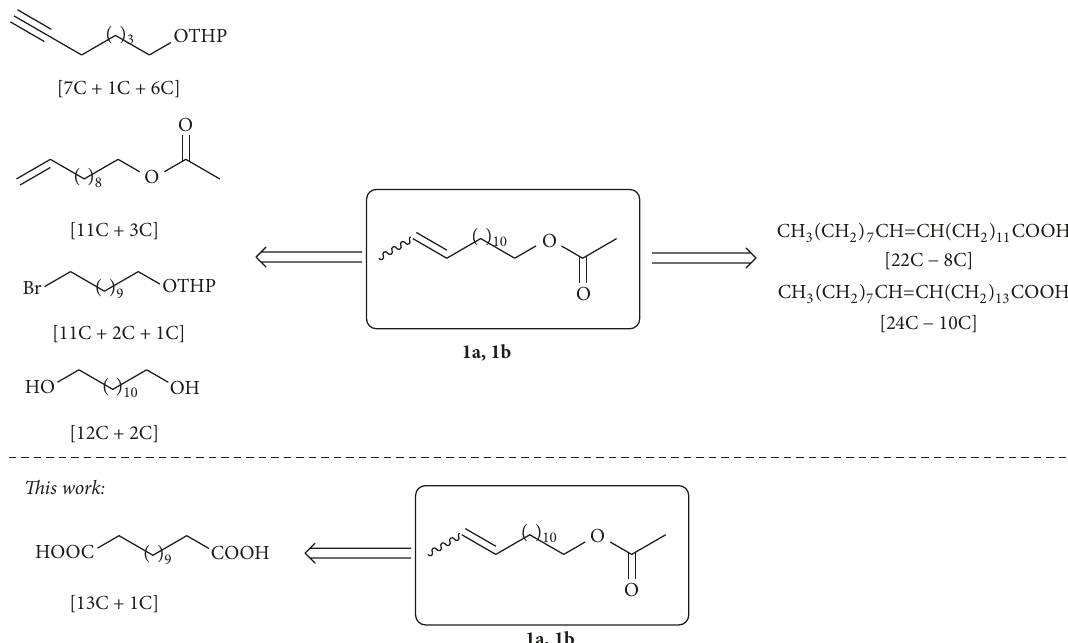
Scheme 1: Comparison between the existing literature synthetic strategies and this